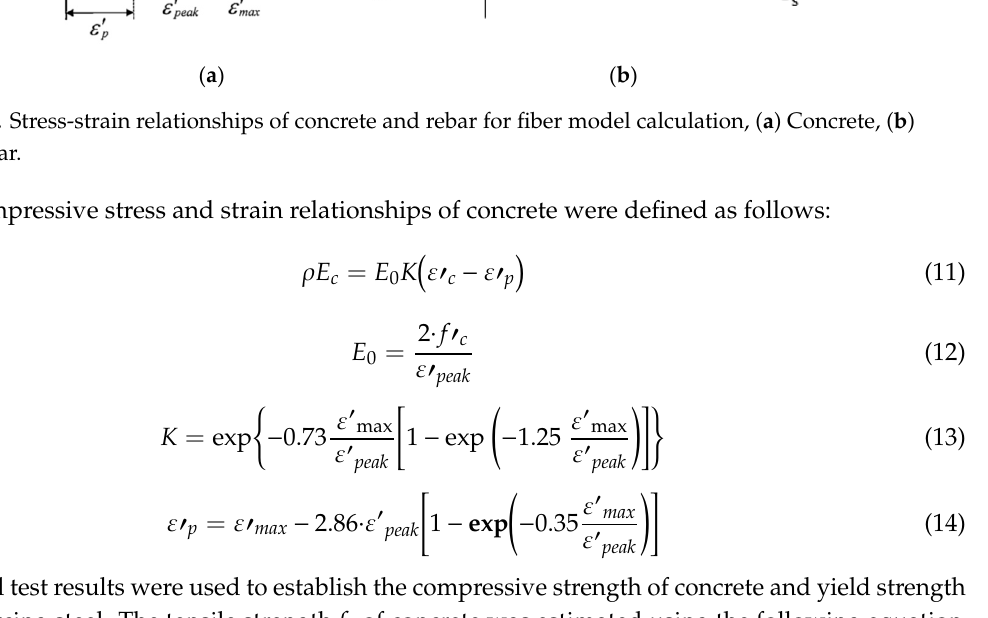
Table 1. List of test specimens used for analysis [9].